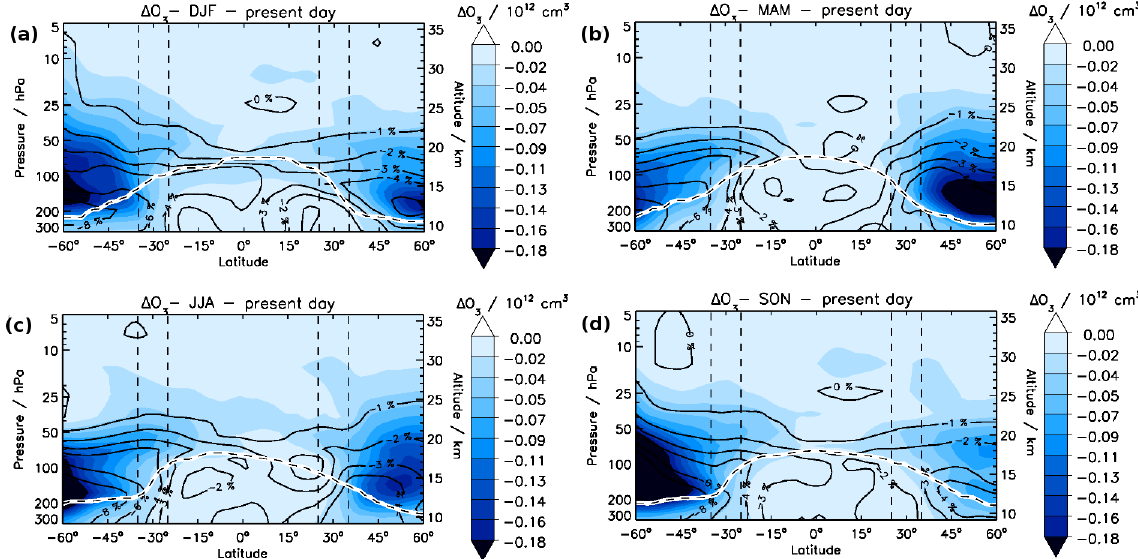
Figure 7. Seasonal zonal mean (cid:49) O 3 distributions during the present-day period.